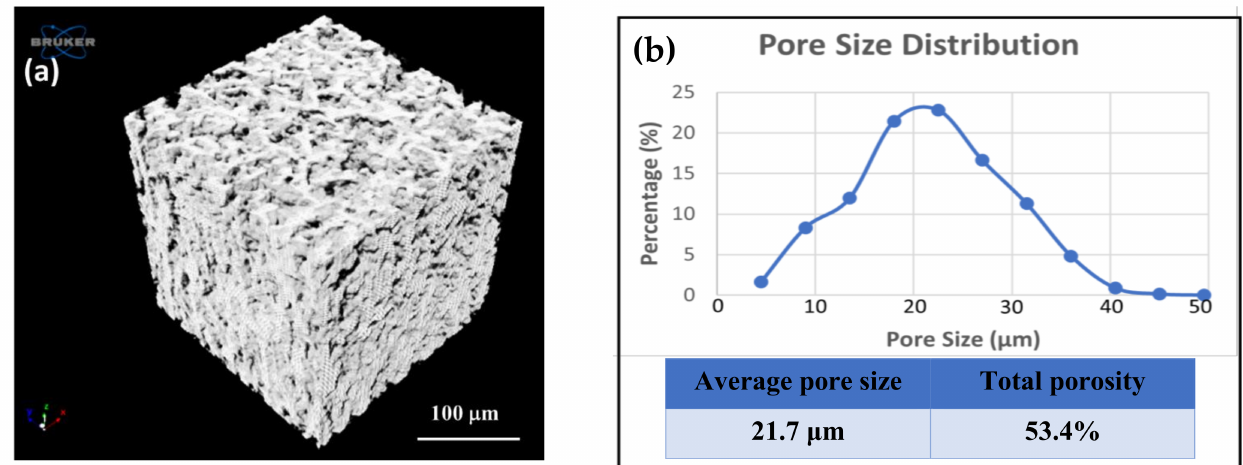
Figure 3. Analysis of porous structure and porosity. ( a ) Three-dimensional and compiled micro-CT images show the porous structure of the fabricated methyl propiolate-functionalized poly- p -xylylene. ( b ) Pore size distribution based on micro-CT analysis showing an average pore size of 21.7 µ m and a total porosity of